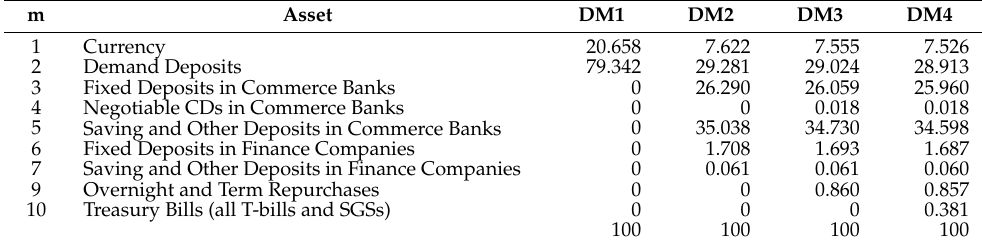
Table 3. Growth-rate Weights in the Last Month (Mar 2021), Percentages.